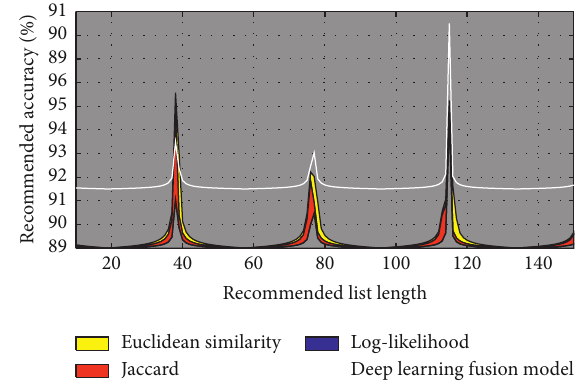
Figure 6: Comparison of the prediction accuracy of Top- N rec- ommends different values of N .